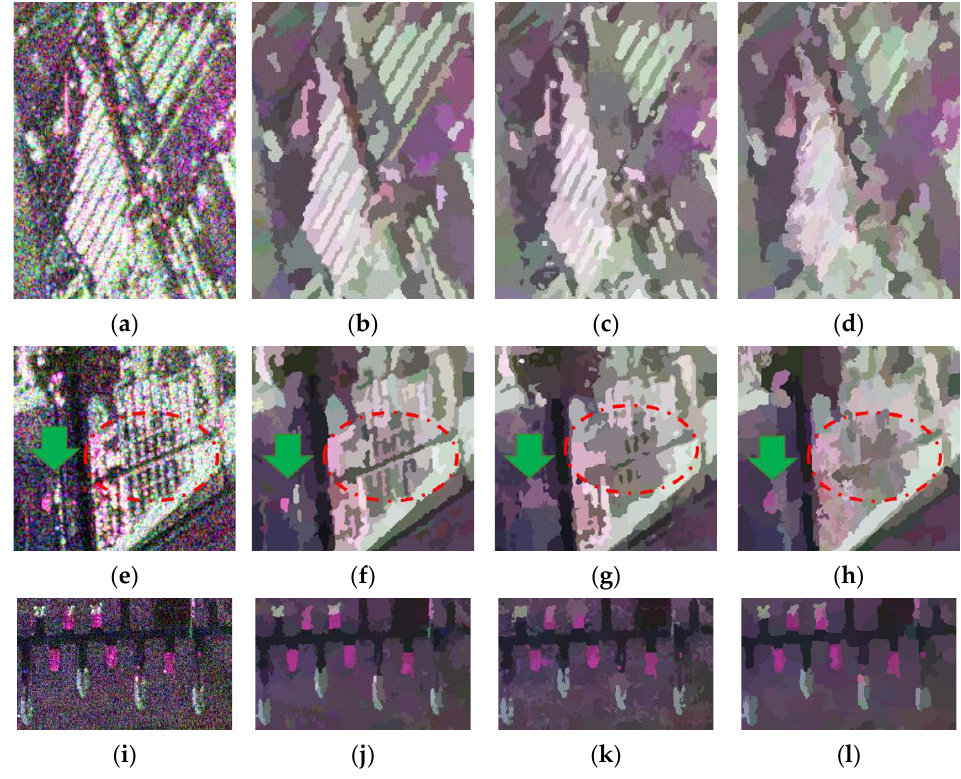
Figure 6. Detailed comparison of segmentation results of different algorithms enlarged from the yellow rectangles in Figure 4a; ( a ), ( e ) and ( i ) enlarged original areas; ( b ), ( f ) and ( j ) results derived from the proposed method; ( c ), ( g ) and ( k ) results derived from the Pol-ASLIC; ( d ), ( h ) and ( l ) results derived from the Pol-ERM.